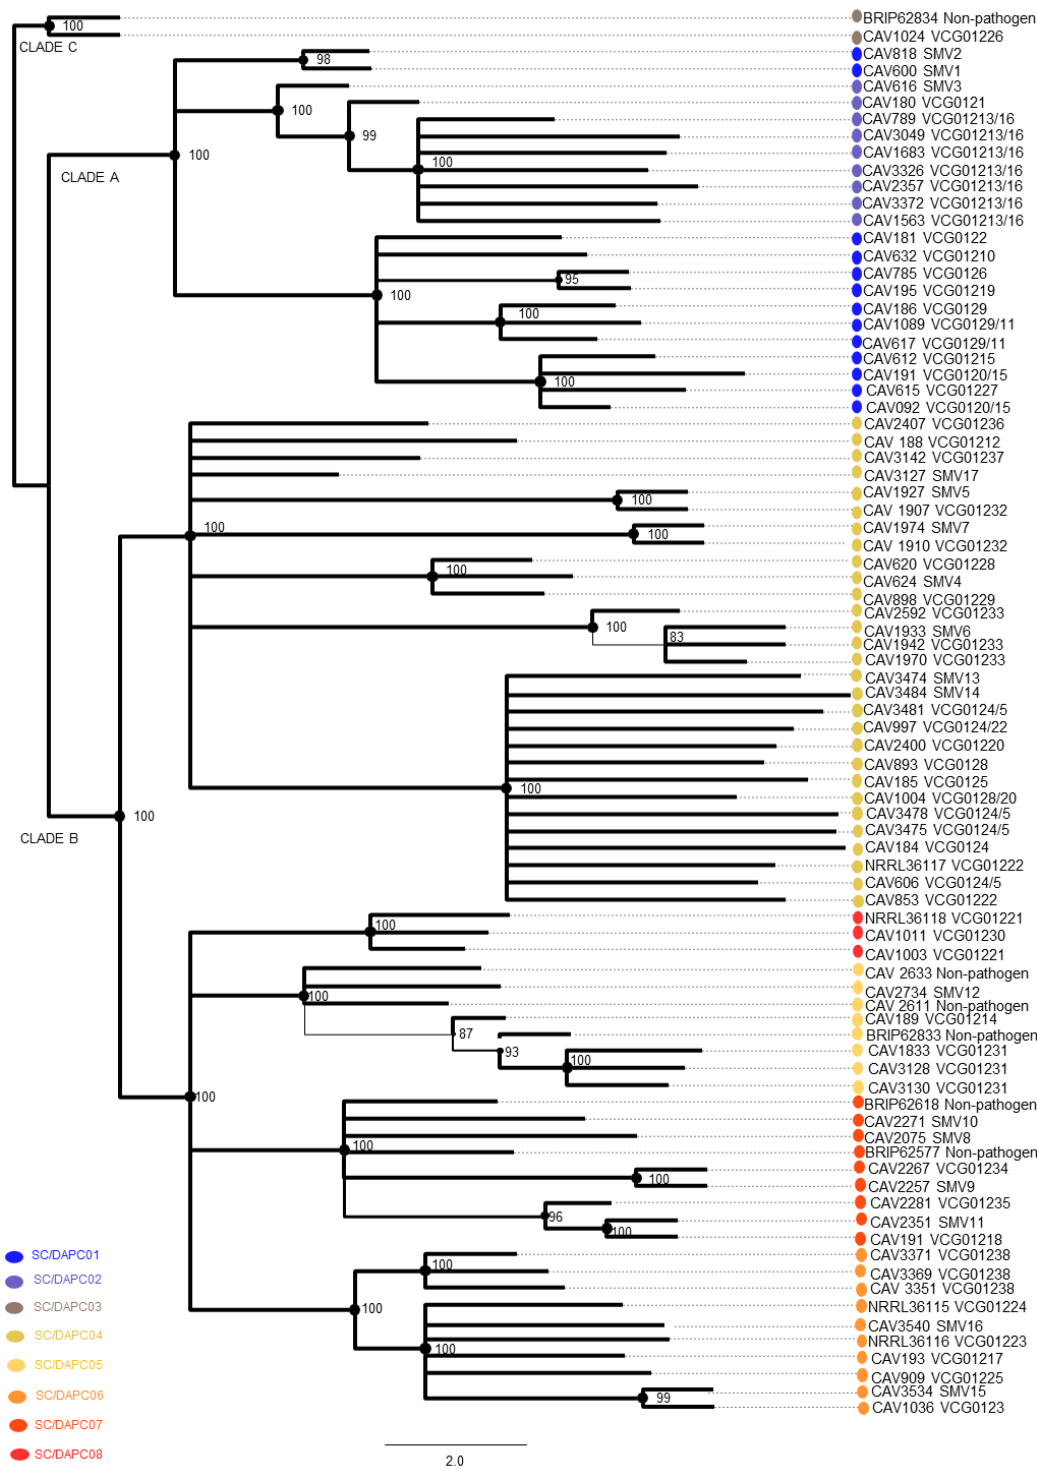
Figure 3. Maximum likelihood analysis of 83 Fusarium oxysporum f. sp. cubense isolates based on single nucleotide polymorphisms. Bootstrap values generated from the maximum likelihood analysis are shown at the internodes. Clade designation (A – C) acco rding to O’Donnell et al. [40] and vegetative compatibility group (VCG) or single member VCG are indicated on nodes.